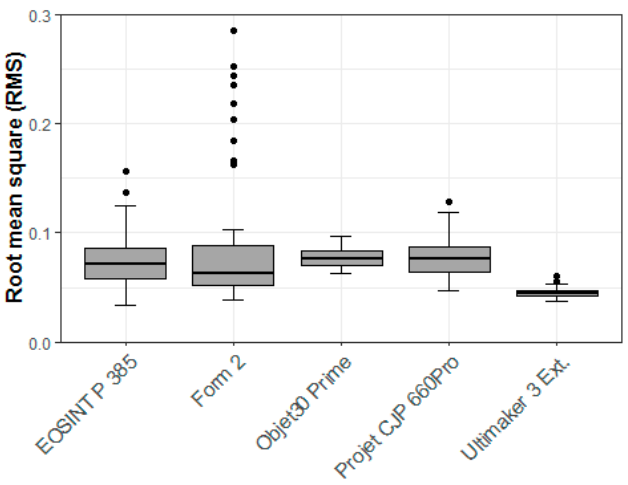
Figure 10. Box plot demonstrating precision RMS (mm) values by 3D printer type.